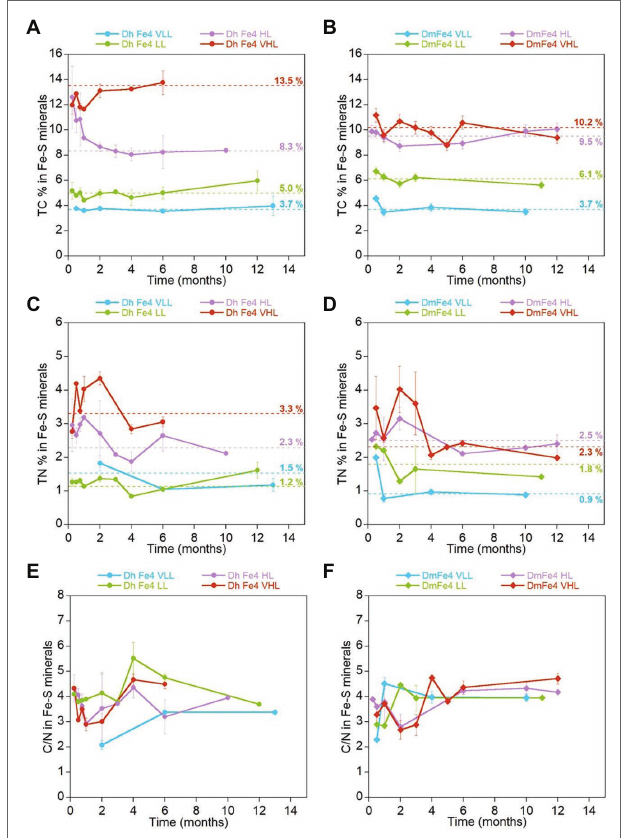
FIGURE 2 | Evolution of the average total carbon (TC) content (w/w %), average total nitrogen (TN) content (w/w %), and average C/N ratio in iron sulfide minerals precipitated in the presence of Desulfovibrio hydrothermalis AM13 (A,C,E) and in the presence of Desulfovibrio magneticus RS-1 (B,D,F) as a function of time. Error bars represent ±one standard deviation. Incubations were performed with four different initial lactate concentrations (VLL, LL, HL, and VHL) which controlled the amount of sulfate reduced and biomass produced ( Table 1 ; Figure 1 ). Results presented here are from minerals produced in cultures that were grown in the presence of Fe(II). Average values of stabilized levels of TC and TN (see Table 3 for data points encompassed in stabilized values) are indicated over dashed lines (A-D) . TC and TN contents in iron sulfide minerals increase with increasing lactate concentrations in the medium (corresponding to increasing concentrations of reduced sulfate, i.e., increasing concentrations of cell biomass). CN ratios stabilize to a narrow range of values for both